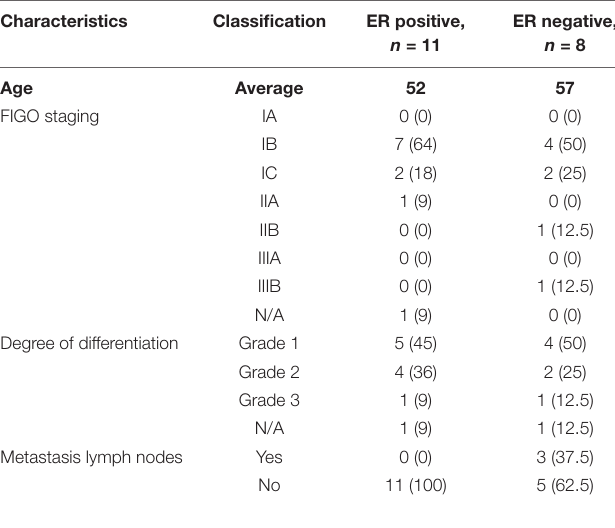
TABLE 1 | Patient demographics and tumor